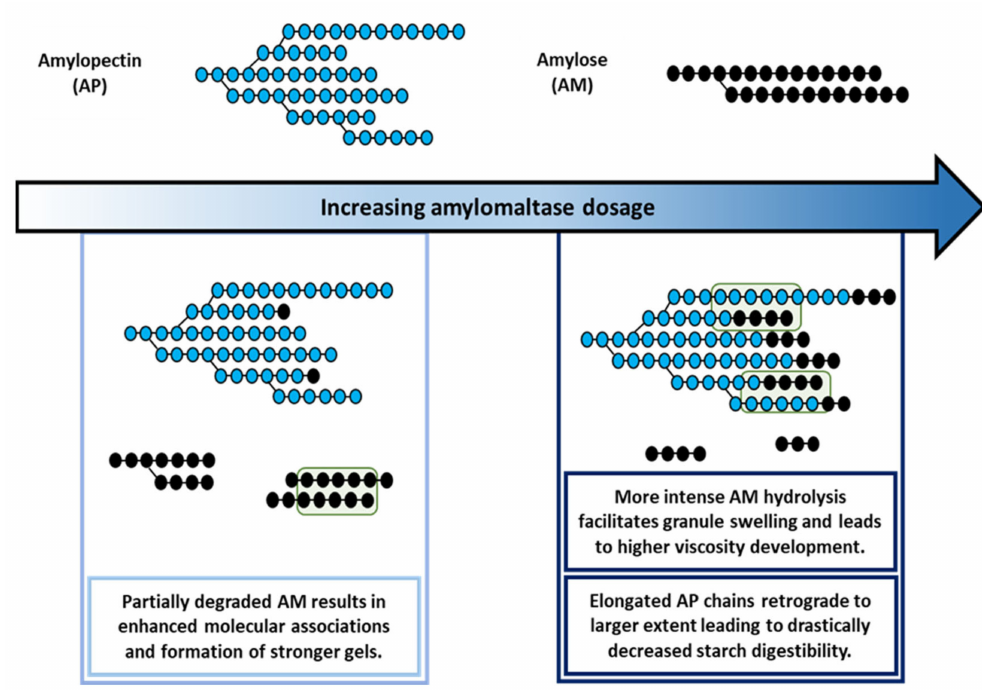
Figure 5. Schematic illustration of the molecular structures of amylose (AM) and amylopectin (AP) obtained by amylomal- tase (AMM) treatment with various dosages during rapid visco analysis (RVA). Blue and black circles represent AP and AM building units, respectively. The schematic representation does not reflect the relative molecular weights and sizes of the two polymers. The green box illustrates the enhanced interactions between